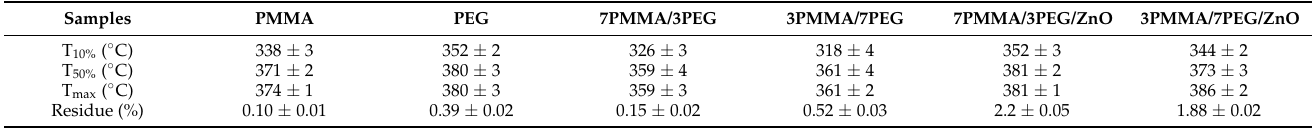
Table 4. Thermal stability of neat polymers, blends and nanocomposites by